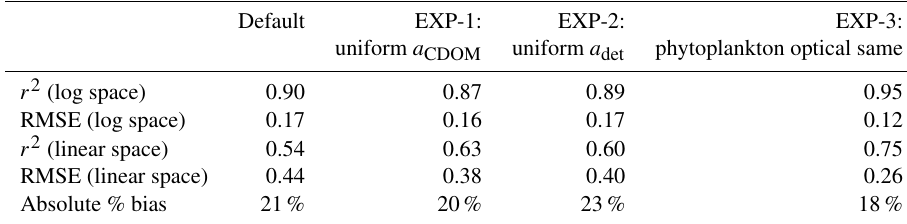
Table 3. Results of the comparison between model “actual” and model “satellite-like” derived Chl a for the sensitivity experiments discussed in Sect. 5. All “satellite-like” derived Chl a were calculated using the GS approach. “Default” is the full experiment discussed in Sect. 3, but with monthly R RS used to calculate the algorithm coefficients. Statistics are calculated for each grid cell and each month over 13 years, except for grid cells and times with low light, very low Chl a and shallow regions (see text). Default EXP-1: EXP-2: EXP-3: uniform a CDOM uniform a det phytoplankton optical same r 2 (log space)